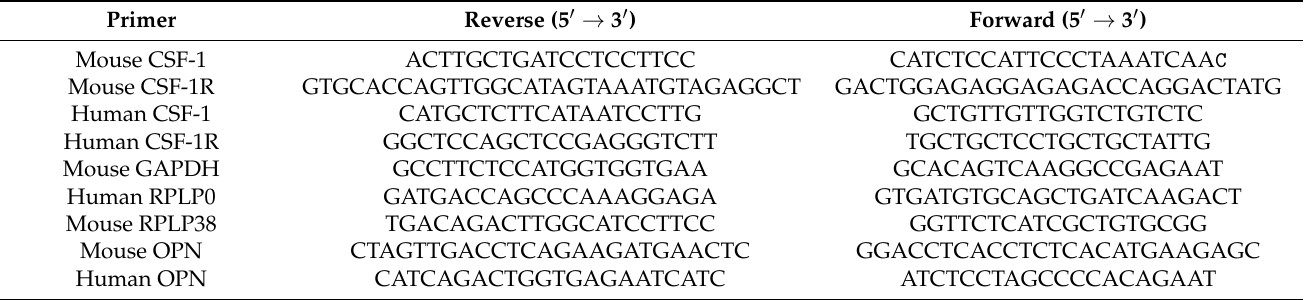
Table A1. Primers for